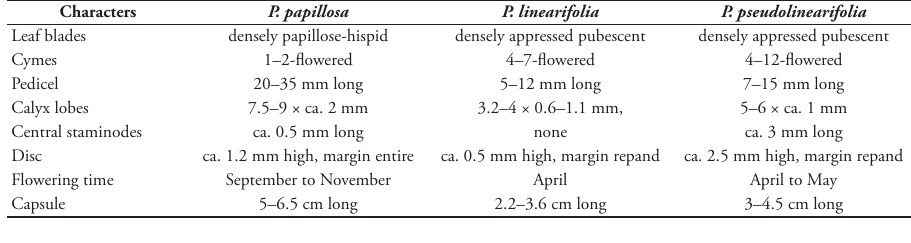
Table 1. Detailed comparison of Primulina papillosa and its two relatives. Characters Leaf blades